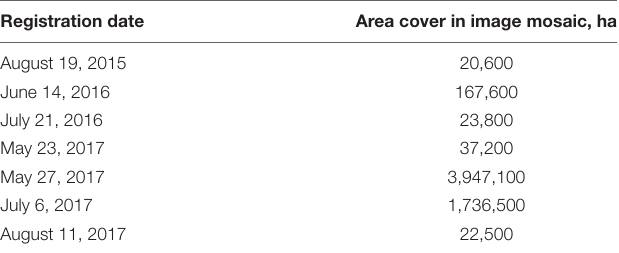
TABLE 3 | Registration dates for Sentinel-2 images used in the study and the area covered at each registration